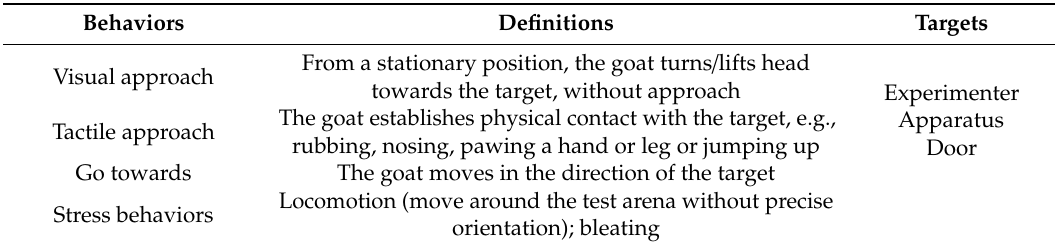
Table 1. Ethogram applied for the study. All behaviors are mutually exclusive, except for the bleating. Behaviors Definitions From a stationary position, the goat turns / lifts Visual approach